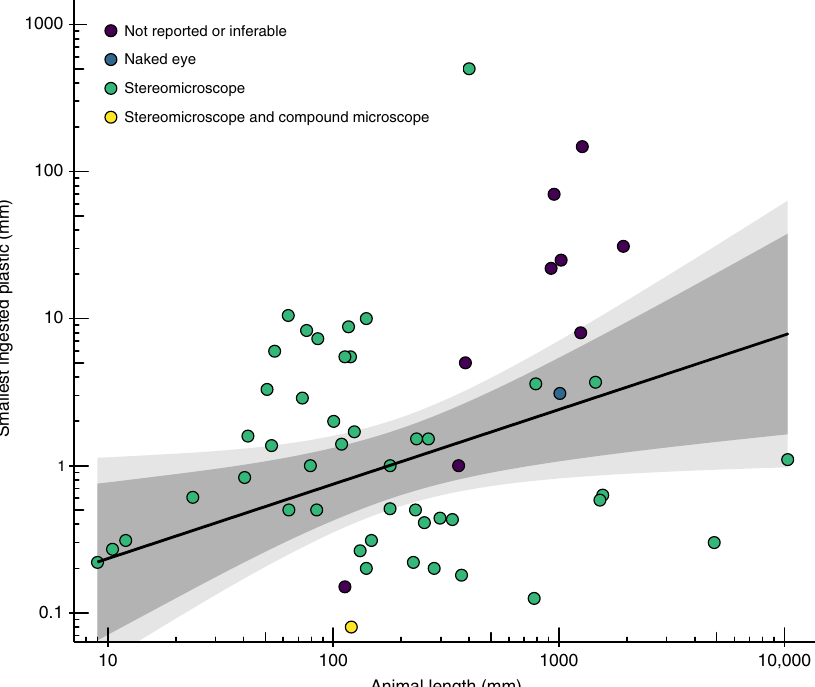
Fig. 3 Detection limits scale with animal size. Studies of larger animals tended not to specify the use of magnifying equipment. Weak relationship (log10- log10 linear regression; R 2 = 0.10, F 1,61 = 7.58, p = 0.008), including 99% (light grey) and 95% (dark grey) CIs, between animals and the smallest piece of ingested plastic found during gut surveys (plastics measured along their longest axes; n =